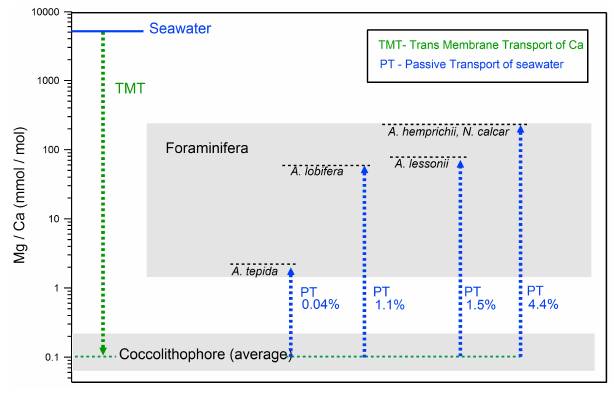
Fig. 3. A new model for trace-element compositions in Foraminifera tests. The full range (grey fields) and the average Figure 3: A new model for trace element compositions in foraminifera tests. The full range (grey 271 Mg/Ca ratios (hatched lines) are indicated for coccolithophores fields) and the average Mg/Ca ratios (hatched lines) are indicated for coccolithophores and for 272 and for four species of Foraminifera, spanning the entire range of four species of foraminifera, spanning the entire range of observed Mg/Ca ratios (c.f Table S1). 273 observed Mg/Ca ratios (cf. Table A1). See text for See text for discussion. 274